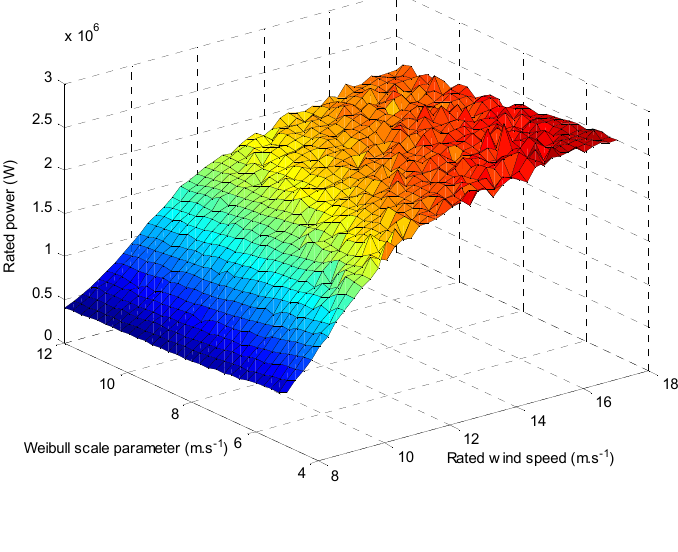
Figure 8. Variation of rated power for optimized wind turbines with respect to rated wind speed and the Weibull scale